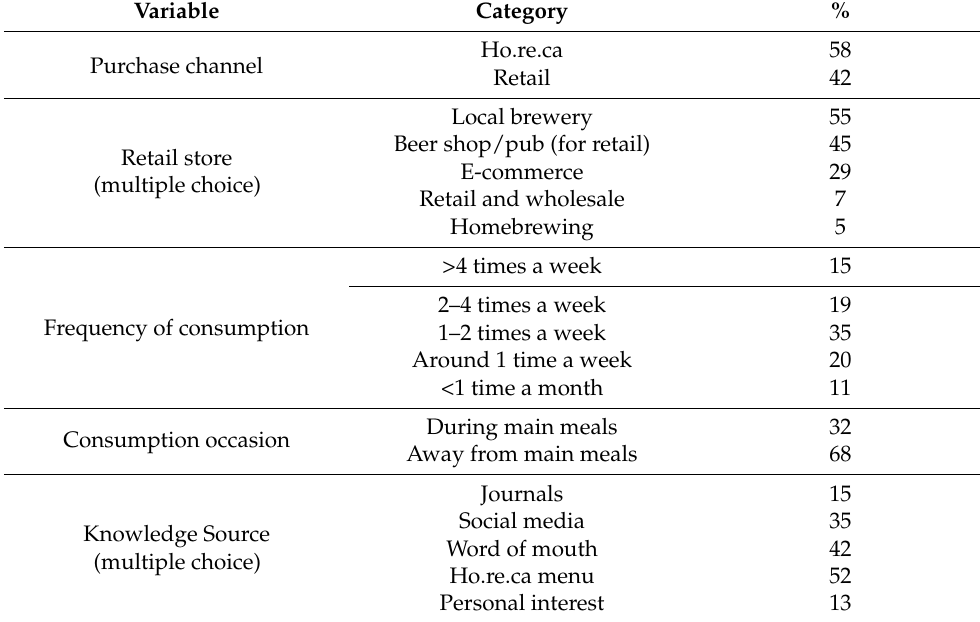
Table 3. Consumer behaviors of the